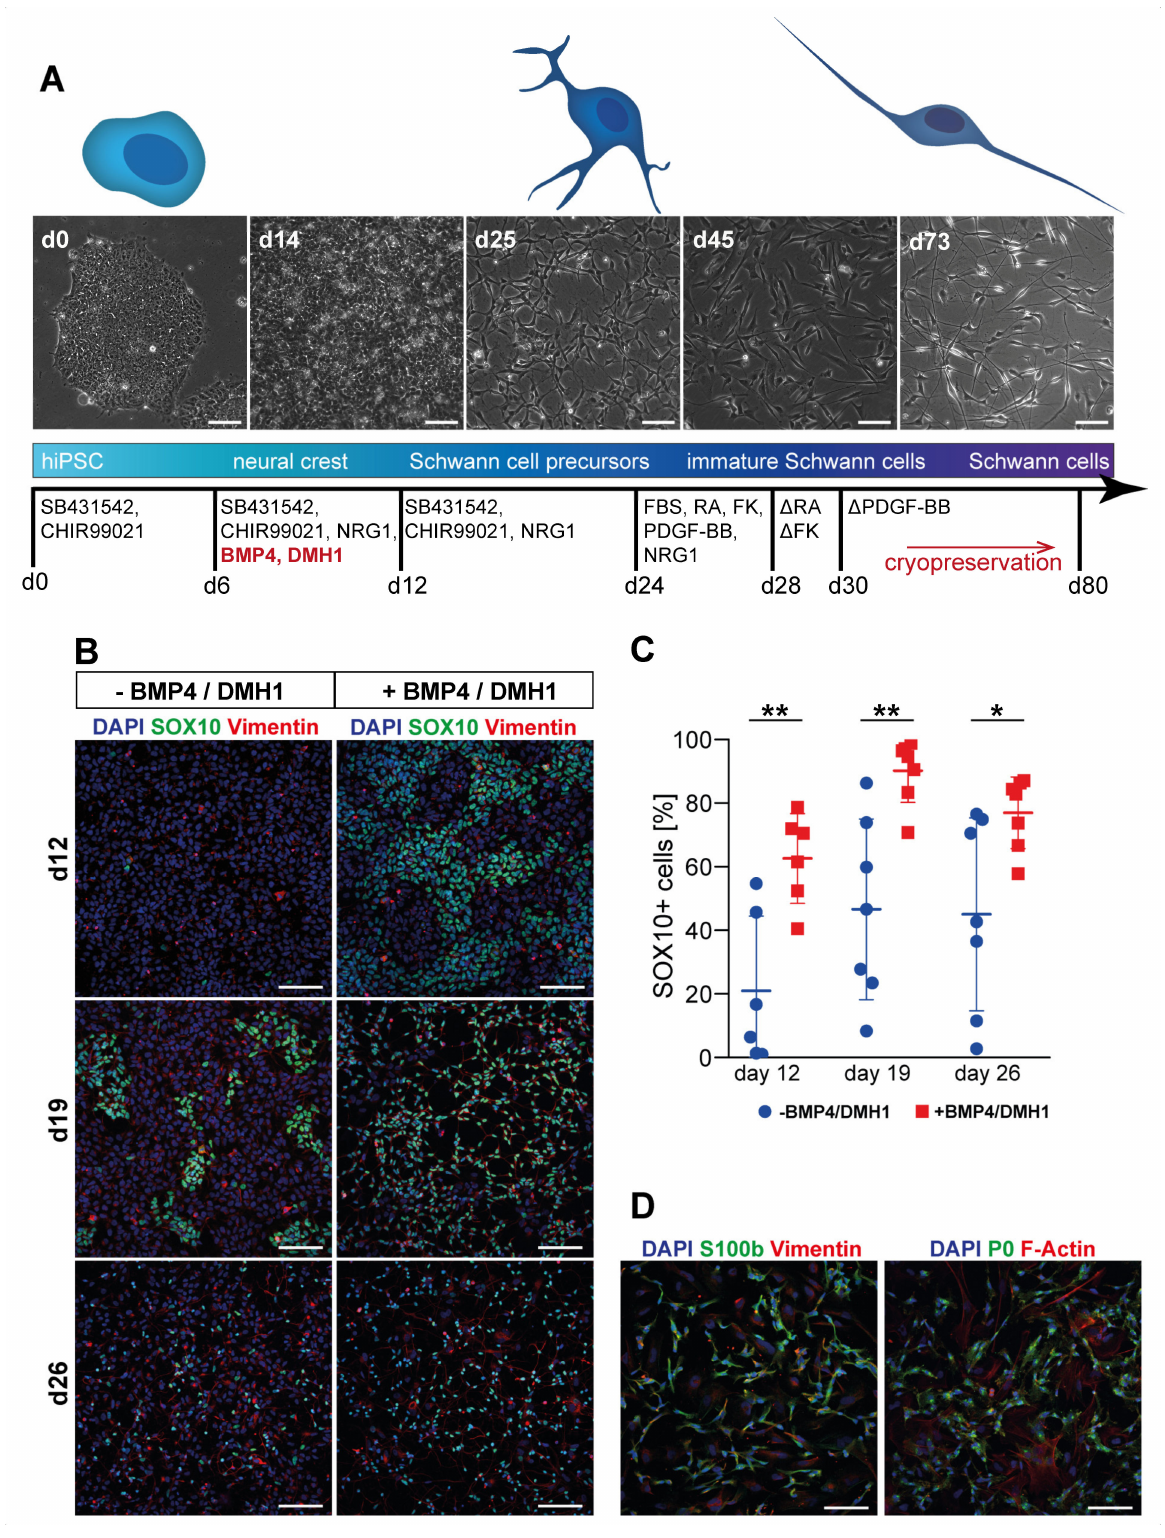
Figure 3. Robustness of Schwann cell differentiation is increased by defined activation of BMP signaling. ( A ) Schematic representation of protocol timeline and differentiation factors used. Micrographs show representative brightfield images of cell populations at differentiation times as indicated on the top left of each image. SC were obtained after 30–40 days of differentiation but could be cultured and further matured until at least day 100; cryopreservation could be performed at every passage. Scale bars: 100 µ m. ( B – D ) hiPSC were differentiated according to the protocol shown in A. Control of BMP signaling was either applied (+ BMP4/DMH1) or left out (- BMP4/DMH1). Samples were fixed at time points as